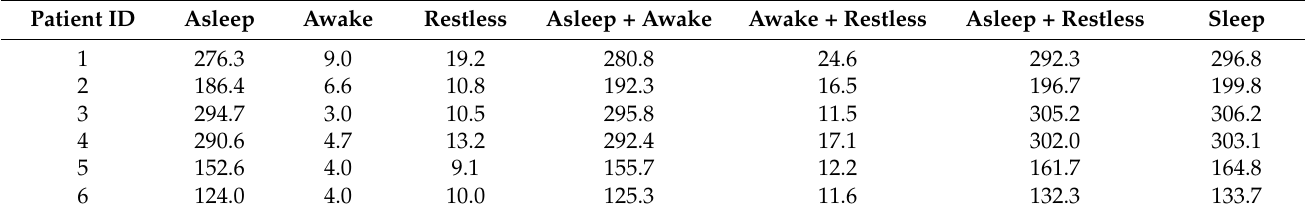
Table A7. Mean Fitbit sleep duration over the entire Fitbit observation time (27